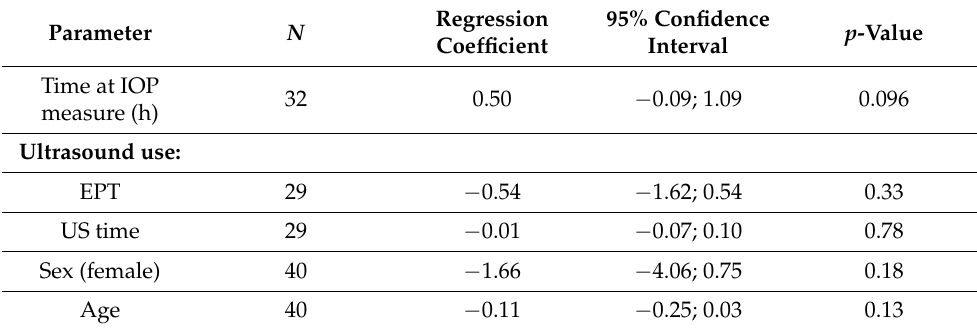
Table 2. Results of the one-at-a-time linear regression analysis between the change in intraocular pressure (dependent variable) and the studied parameters.